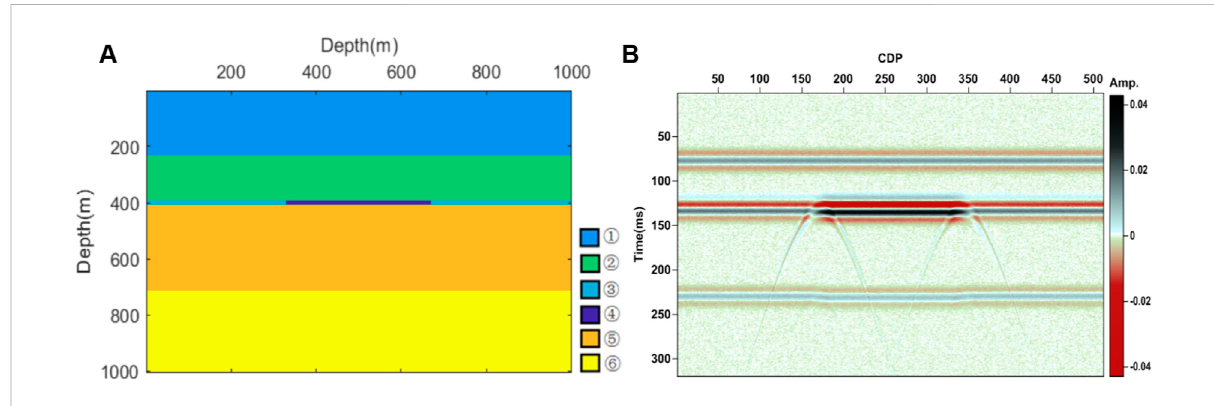
FIGURE 1 The geological model (A) and its corresponding seismic response with added Gaussian noise. SNR=15 dB (B) .